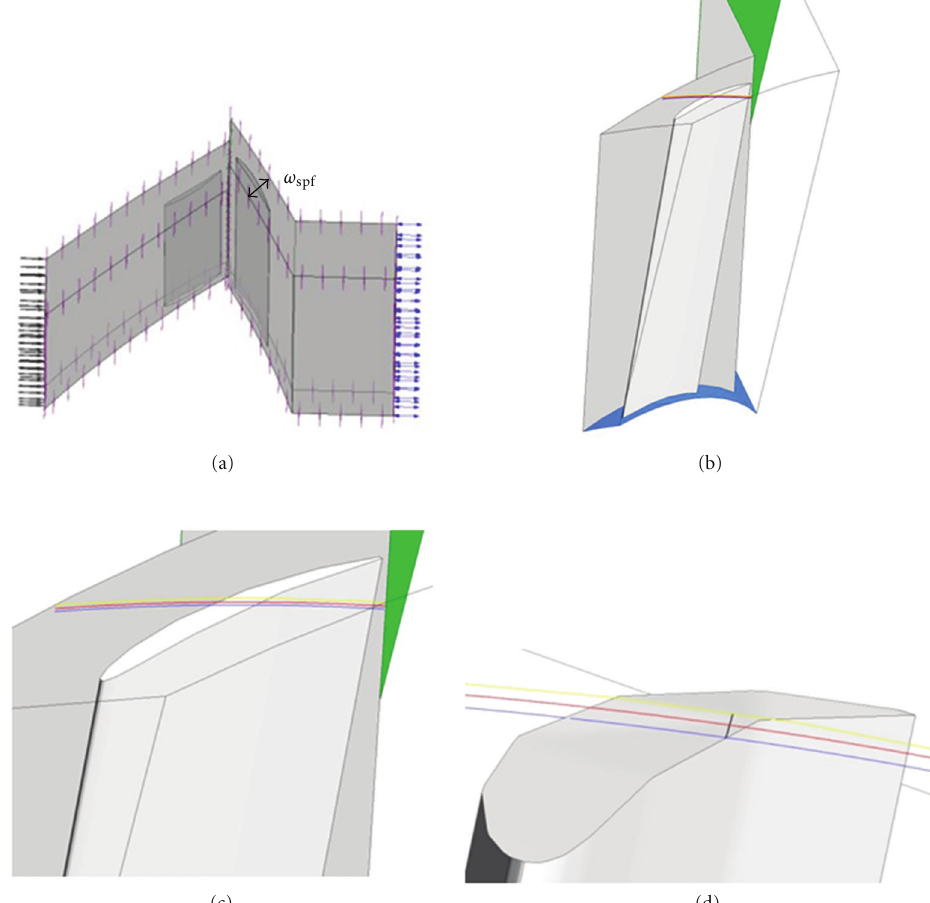
Figure 4: (a) Three-dimensional blade model showing blade vibration direction. (b) Three-dimensional model showing polylines where the pressure is observed. (c) Zoomed polylines. (d) Polylines and vertical line across blade tip/casing gap where the pressure is observed.